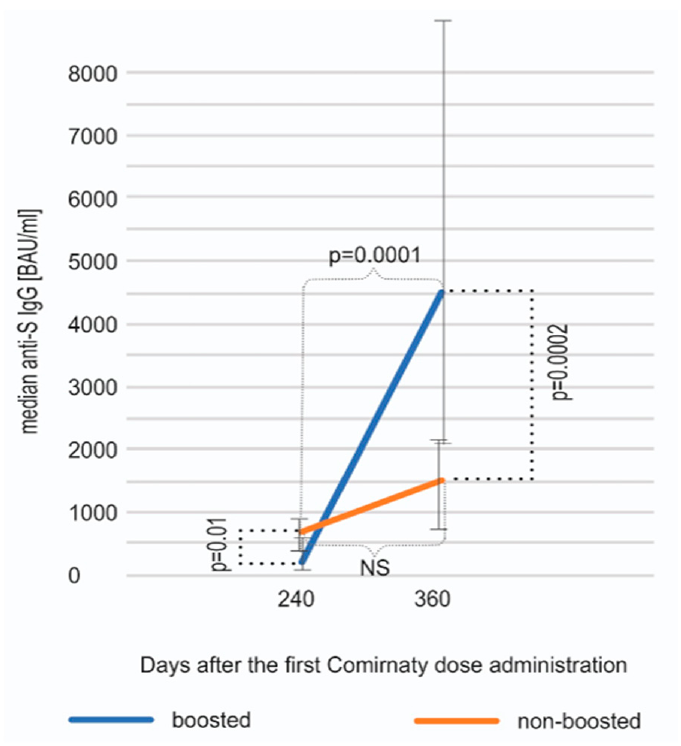
Figure 2. An increase in anti-spike SARS-CoV-2 IgG antibodies between days 240 and 360 shown separately for individuals boosted and non-boosted. The results are shown as medians and interquar- tile ranges (Q25, Q75). The rise was statistically significant only in the boosted subcohort ( p = 0.0001, Wilcoxon test). On day 360, the boosted subjects displayed, as expected, a statistically significantly higher median anti-S IgG concentration ( p = 0.0002, Mann–Whitney U test). These two groups were divided further based on their recent (between days 240 and 360) SARS-CoV-2 infection, that was defined as an emerging anti-N seropositivity, in some cases confirmed by direct virus detection (Figure 3). The largest group (n = 72) included participants who had received a booster but had not been infected between day 240 and 360 (boosted, non-infected; B,